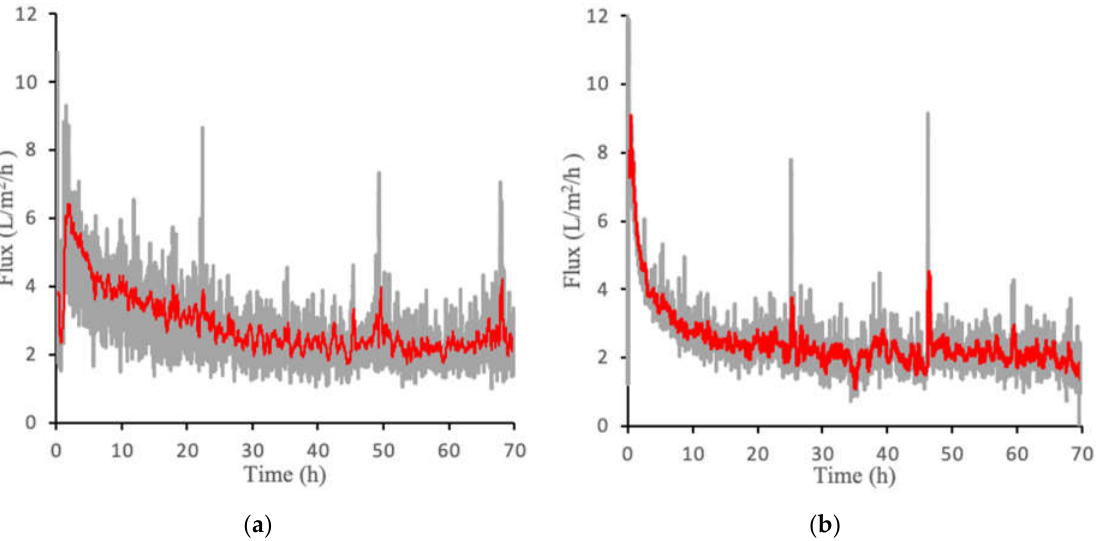
Figure 5. Crossflow flux measurements for ( a ) PAA-Na at 0.3 g/mL and ( b ) PAMA-Na at 0.3 g/mL. The gray lines represent the raw data generated from three separate experiments and the red line represents the 20-point moving average.